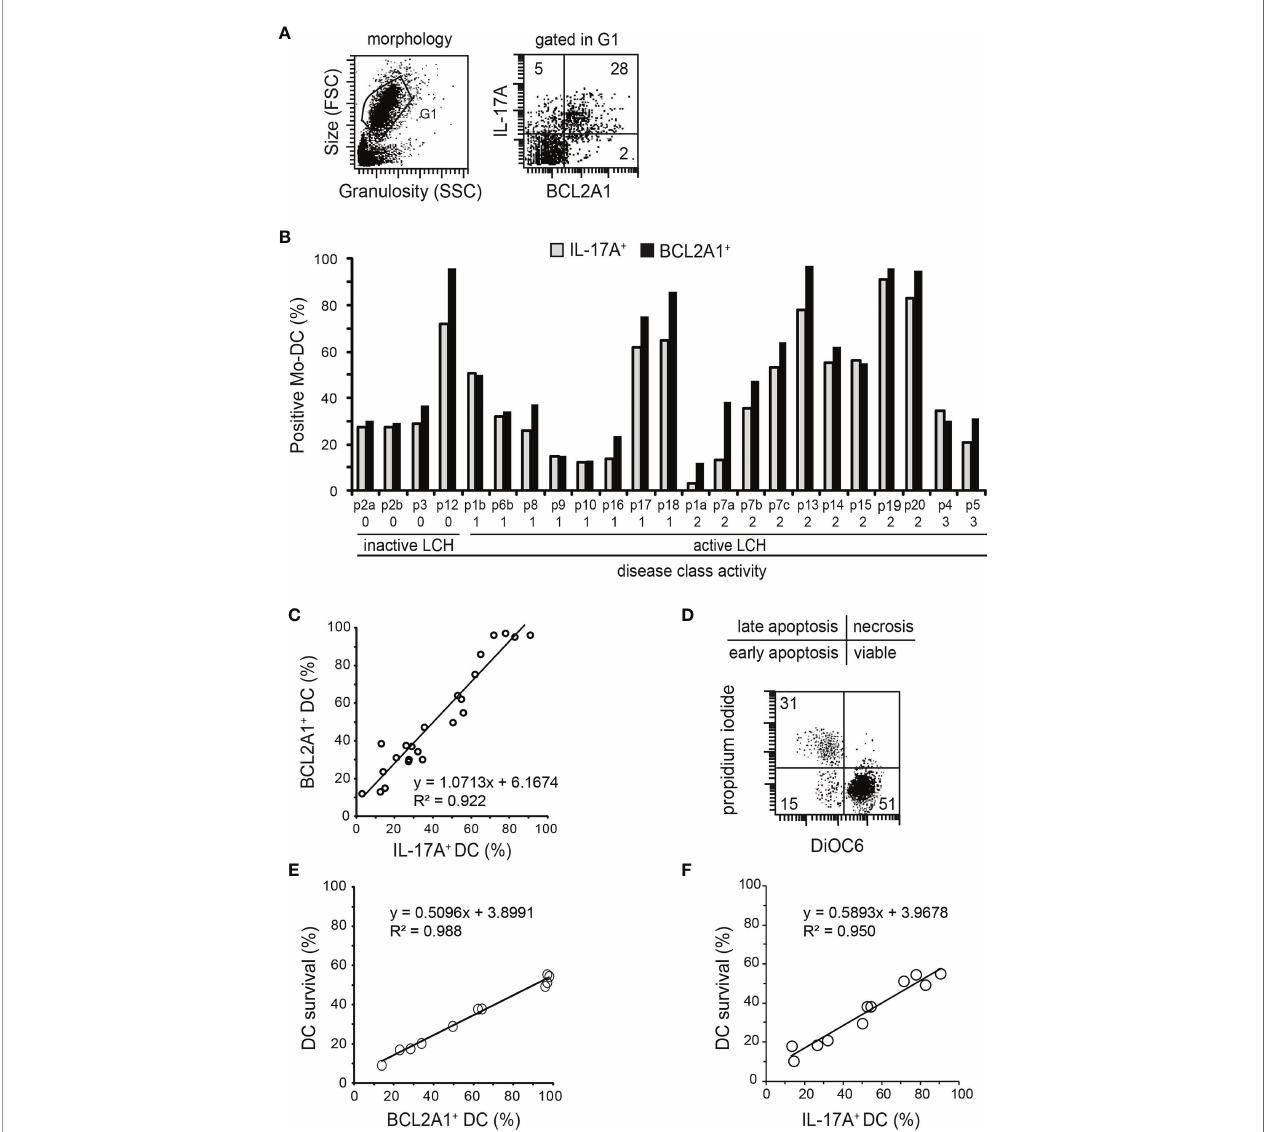
FIGURE 2 | Statistical relationships between intracellular IL-17A and BCL2A1 expression, and/or Mo-DC survival from LCH patients. Flow cytometry analyses after intracellular staining of IL-17A and BCL2A1 in Mo-DCs from LCH patients (n=23 samples from 20 patients). (A) Representative dot plots of Mo-DC morphology (left) and their expression of BCL2A1 versus IL-17A (right). The numbers indicated in the dot plot correspond to the percentage of the positive cells. (B) Percentages of Mo-DCs expressing IL-17A and BCL2A1. Patients were plotted after ranking individuals according to their disease activity classes (as reported in Table 1 ): 0, Resolution; 1, Mild; 2, Moderate; 3, Marked disease. SD were below 2%. (C) Correlation between IL-17A and BCL2A1 expression in Mo-DCs from LCH patients. (D) Representative dot plot of DiOC 6 PI survival analyses. Percentage of viable Mo-DCs from LCH patients were quanti fi ed after 7 days in culture (initial density of one million Mo-DCs). DiOC + 6 PI – are viable Mo-DCs from LCH patients. (E) Correlation between BCL2A1 expression and survival of Mo-DCs from LCH patients. (F) Correlation between IL-17A expression and survival of Mo-DCs from LCH patients. (C, E, F) Linear regression statistical analyses were performed. y=f(x) indicates the equation of the statistical line of tendency and R 2 the correlation